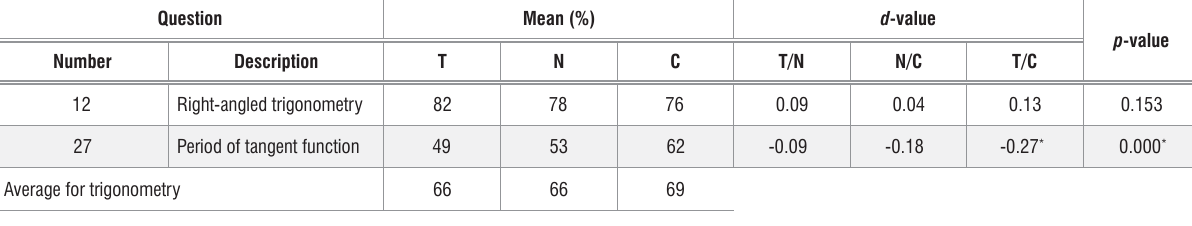
Question by question comparison for